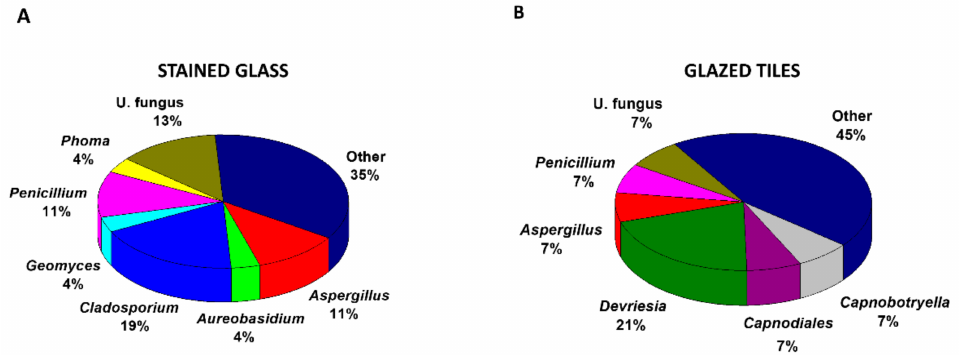
Figure 2. Relative % of fungal genera reported from the 21st literature regarding stained glass and glazed tiles. The category “other” refers to a compilation of several genera that occurs less than 3.4% and “U. fungus” are unidentified fungi. ( A ) Stained glass. ( B ) Glazed